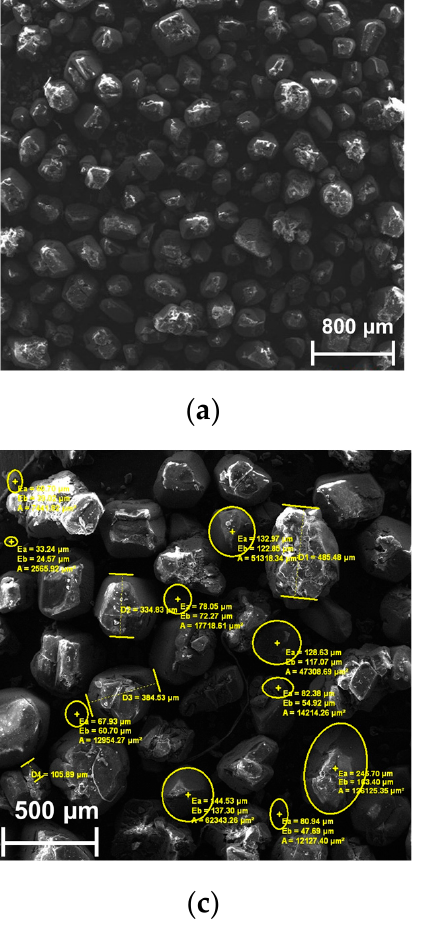
Figure 4. ( a ) HMX used to obtain the new composite HMX-AAc/EtAc; ( b ) HMX recovered from PBX 3; ( c ) raw HMX particle size; ( d ) recovered HMX particle size.